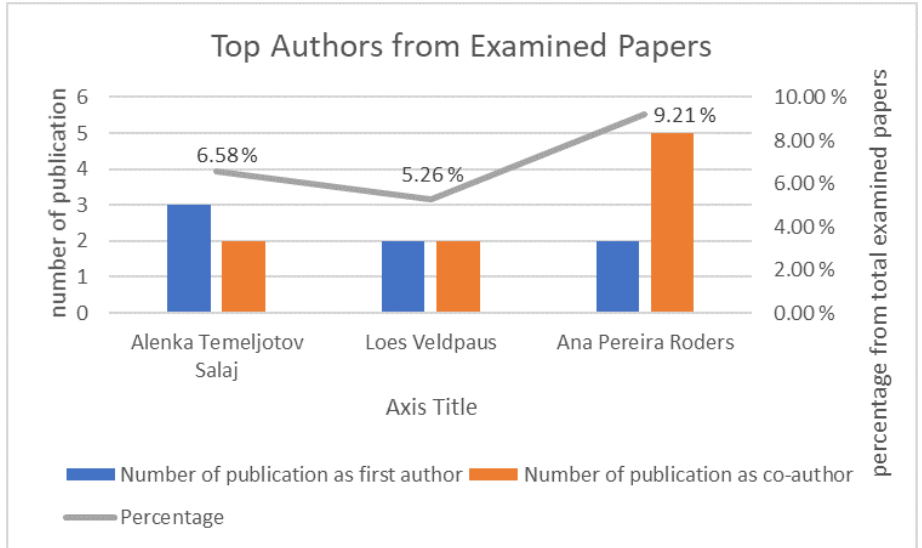
Figure 3. Top authors on urban heritage facility management (UHFM) field.